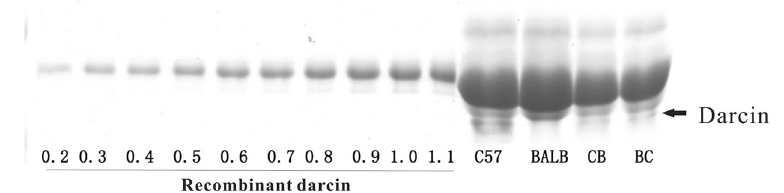
Figure 5. SDS-PAGE of recombinant darcin diluents and urine from C57, BALB, CB and BC male mouse. One microliter sample was used in the analysis. Recombinant darcin was diluted to different concentrations. The value numbers below the band of recombinant darcin refer to the concentration ( μ g/ μ L) of recombinant darcin in corresponding diluents. BC: hybrid of BALB ♀ × C57 ♂ ; CB: hybrid of C57 ♀ × BALB ♂ .